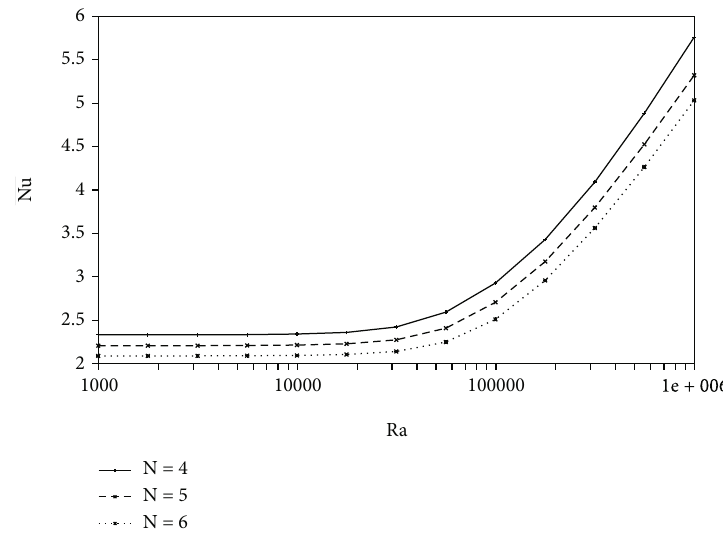
Figure 10: Impact of Rayleigh number and the undulation number on the average Nusselt number at A = 0 : 2 and ϕ = 0 : 03 . Table 3: Di ff erences in the average Nusselt number and Rayleigh number for di ff erent values of the controlling parameters, ϕ , A , and N . N = Ra ϕ